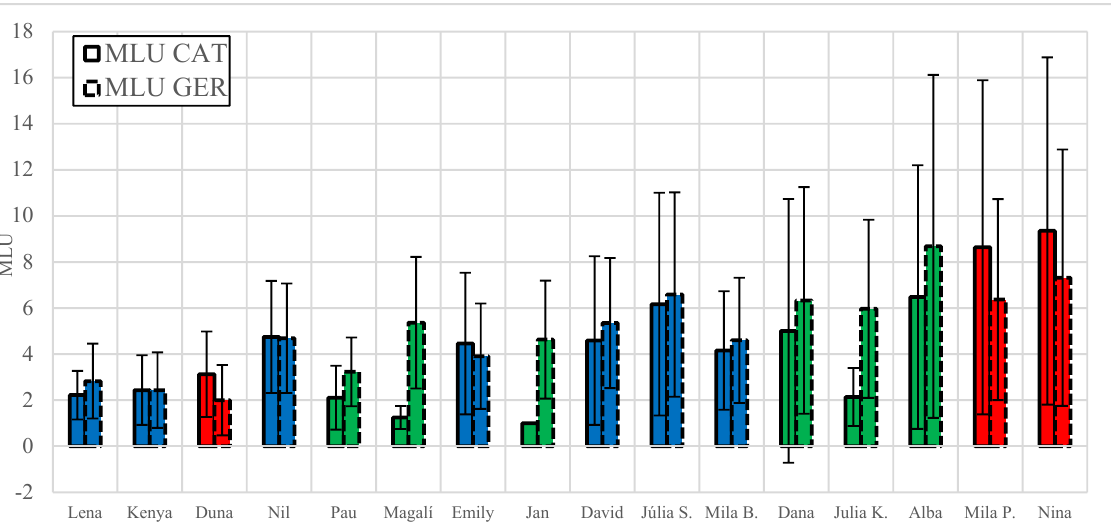
Figure 2. MLU values for Catalan (solid line) and German (dotted line), and language dominance (blue = balanced; green = German dominant; red = Catalan dominant) for the sixteen bi- and trilinguals according to age.